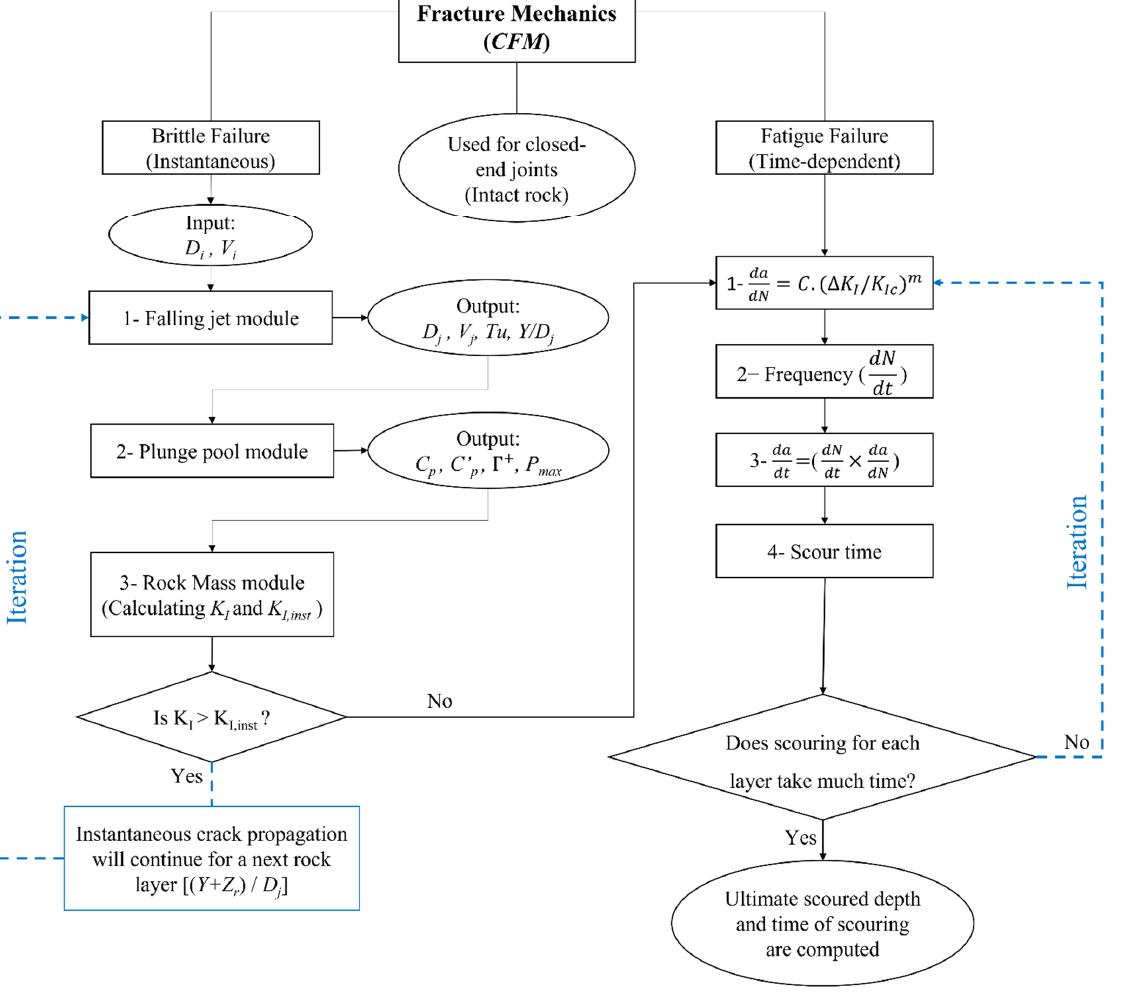
Figure 11. CFM flowchart.